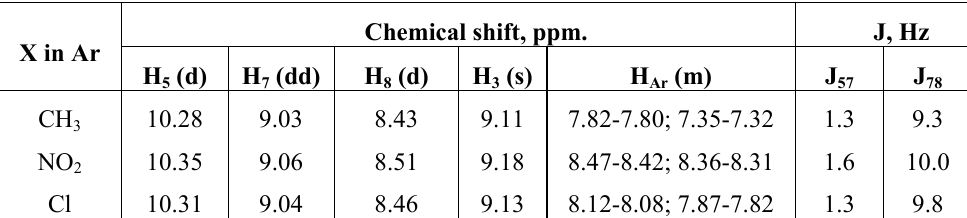
Table 2. 1 H-NMR spectra of the salts II Chemical shift,